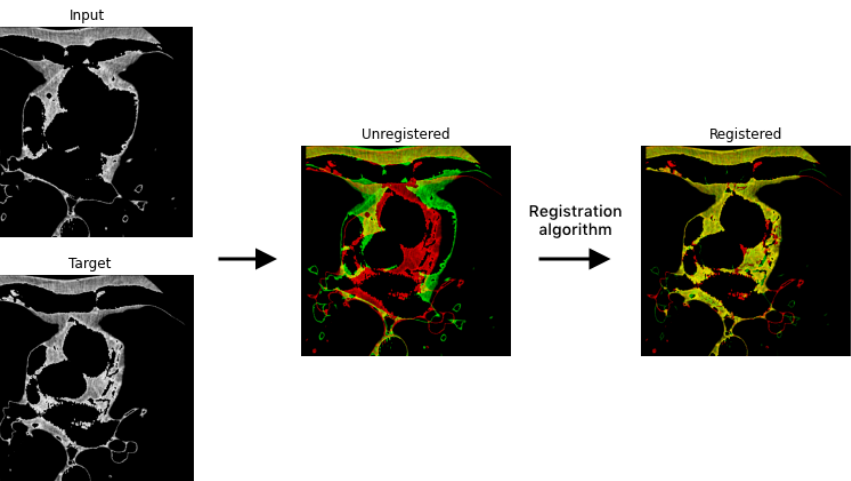
Figure 6. A diagram of the registration process. First, input and target images are selected. On the Unregistered image, both the target and input images are superimposed, with the input image in green and the target image in red. During registration, the input image is deformed to match the target image, while the target stays fixed. The Registered image shows the two images superimposed, but this time it shows the deformed input image as a result of the registration